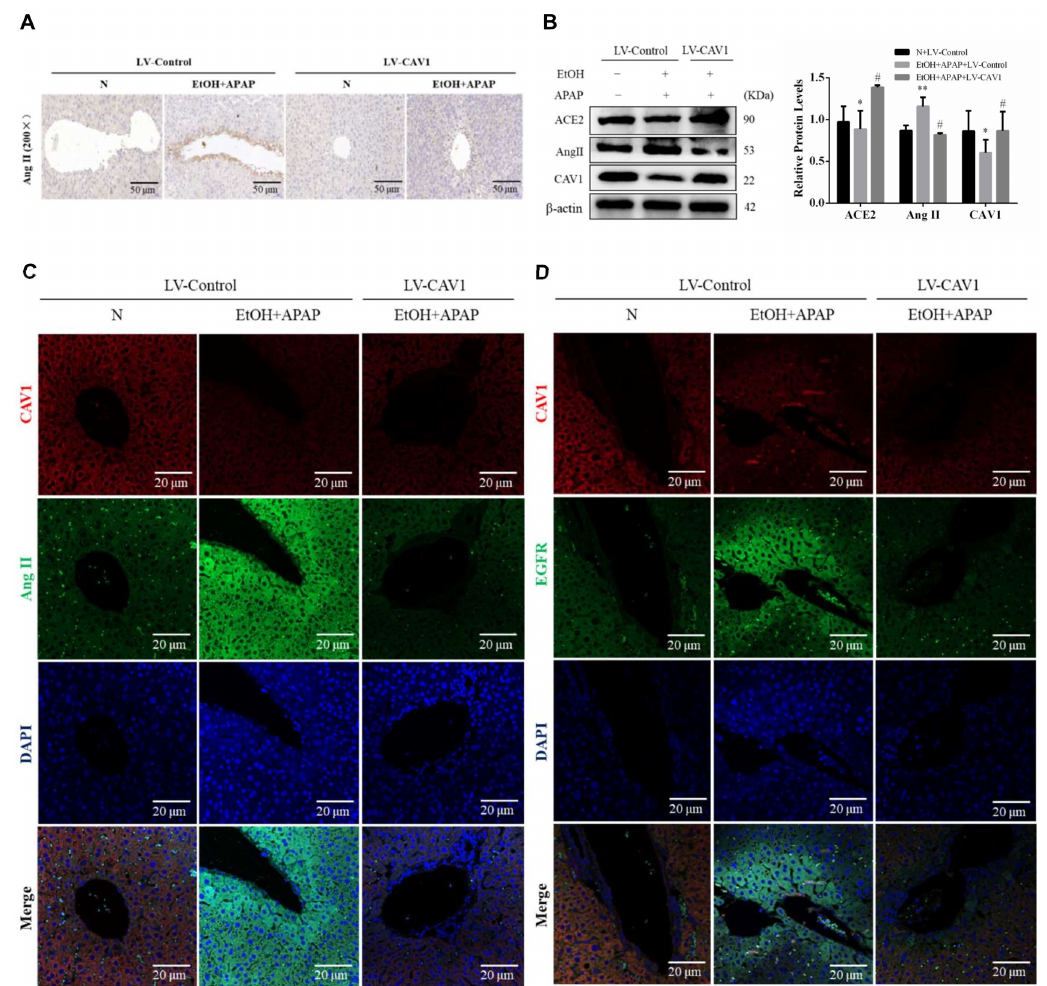
Figure 3. The protein expression of Ang II was inhibited after CAV1 overexpression. ( A ) Representative images of immunohistochemistry results of Ang II for liver tissue sections (Scale bar = 50 µ m). ( B ) Western blot analysis of the relative protein levels of CAV1, ACE2 and Ang II were measured in liver tissue. ( C,D ) Representative images of immunofluorescence double staining results of CAV1 and Ang II as well as CAV1 and EGFR. DAPI was used for nuclear staining (blue). Red color represents CAV1 staining. Green color represents Ang II or EGFR staining (Scale bar = 20 μm). Data represent the mean ± SEM ( n = 8 mice). * p < 0.05 vs. N + LV-Control group; ** p < 0.01 vs. N + LV-Control group; # p < 0.05 vs. EtOH + APAP + LV-Control group.